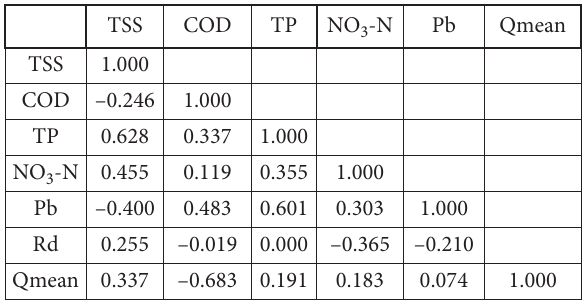
Table 4. Results of correlation